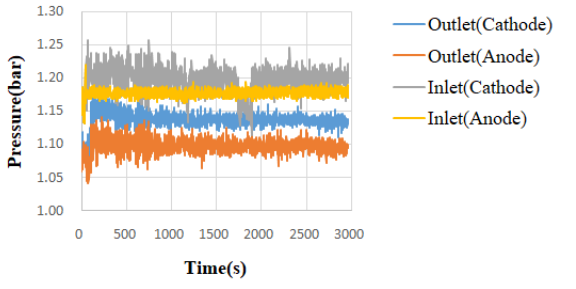
Figure 3. Temperature variation chart of different positions of high-temperature fuel cells.